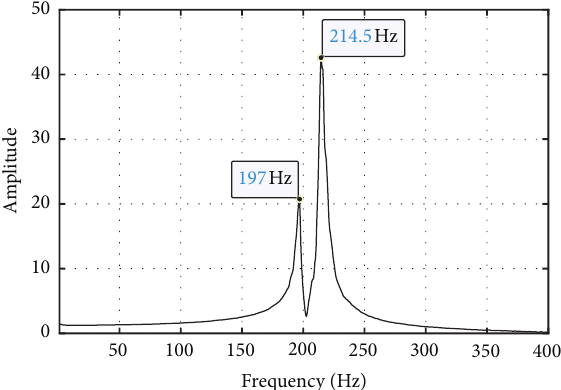
Figure 14: Variation of the identified frequencies with model order when using 􏽥 h ( k ) by IFFT of S ( ω ) .